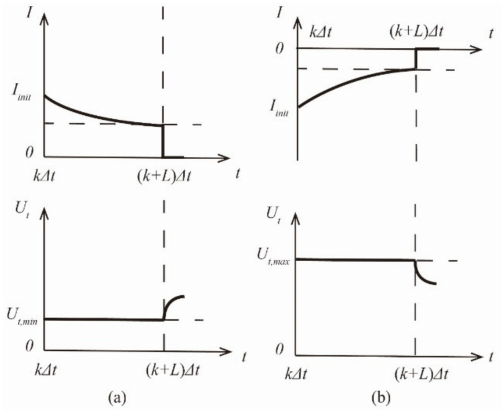
Figure 2. Battery current and terminal voltage in SOP estimation at a constant voltage mode: ( a ) discharge; ( b ) charge.